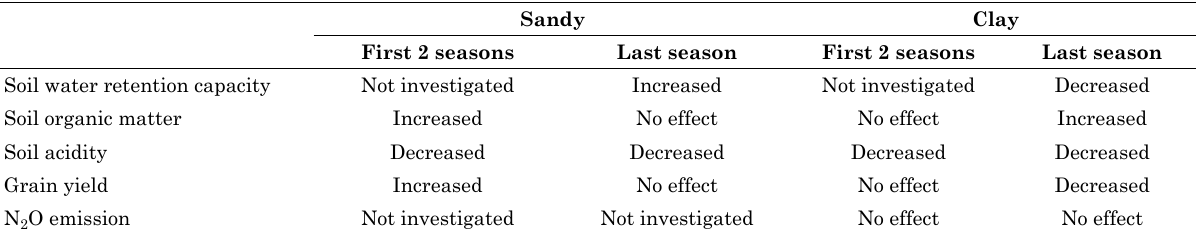
Table 2. Overview of effects of wood biochar amendment on key soil properties and grain yield throughout four (on sandy soil) and five (on clay soil) main growing seasons in the Brazilian Savannah, adapted from Carvalho